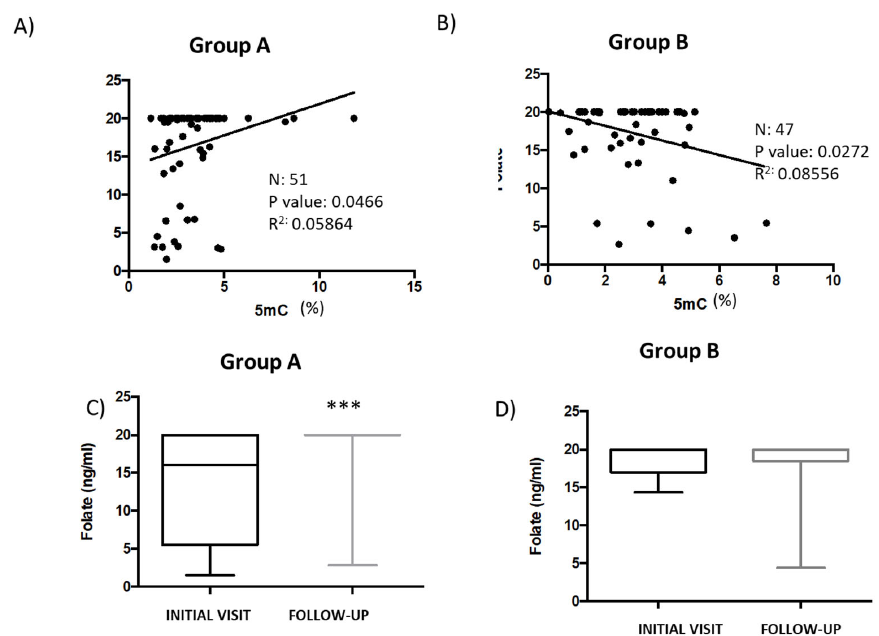
Figure 3. The relationship between folate levels and global DNA methylation in patient serum samples. ( A ) Correlation analysis to test the association between folic acid and 5mC levels in serum samples from patients in Group A ( n = 51) and ( B ) from patients in Group B ( n = 47). Data points indicate individual patient values. Folate levels measured during the initial- and follow-up consults were compared between patients in ( C ) Group A and ( D ) Group B. Data are presented as the mean ± S.E.M; paired t tests (*** p < 0.001). 5mC, 5-methylcytosine.